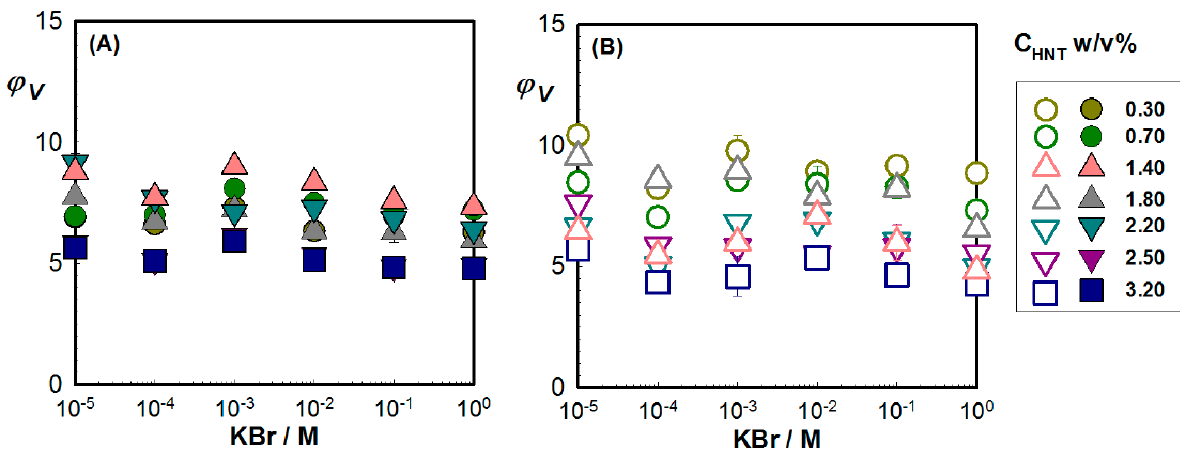
Figure 12. The equilibrium volume swelling ratio ϕ V of HNTm/PHAD-Hgs ( A ) and HNTm/PHAD-Cgs ( B ) as a function of the ionic strength of aqueous salt solutions of KBr.